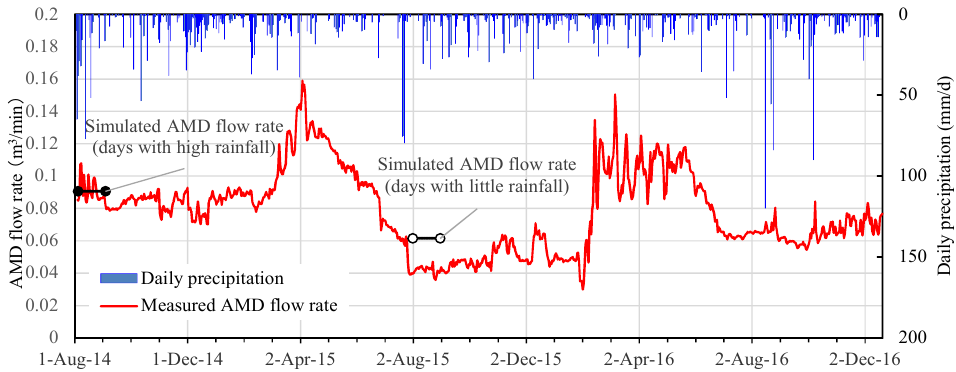
Figure 6. Change of precipitation and AMD flow rate.